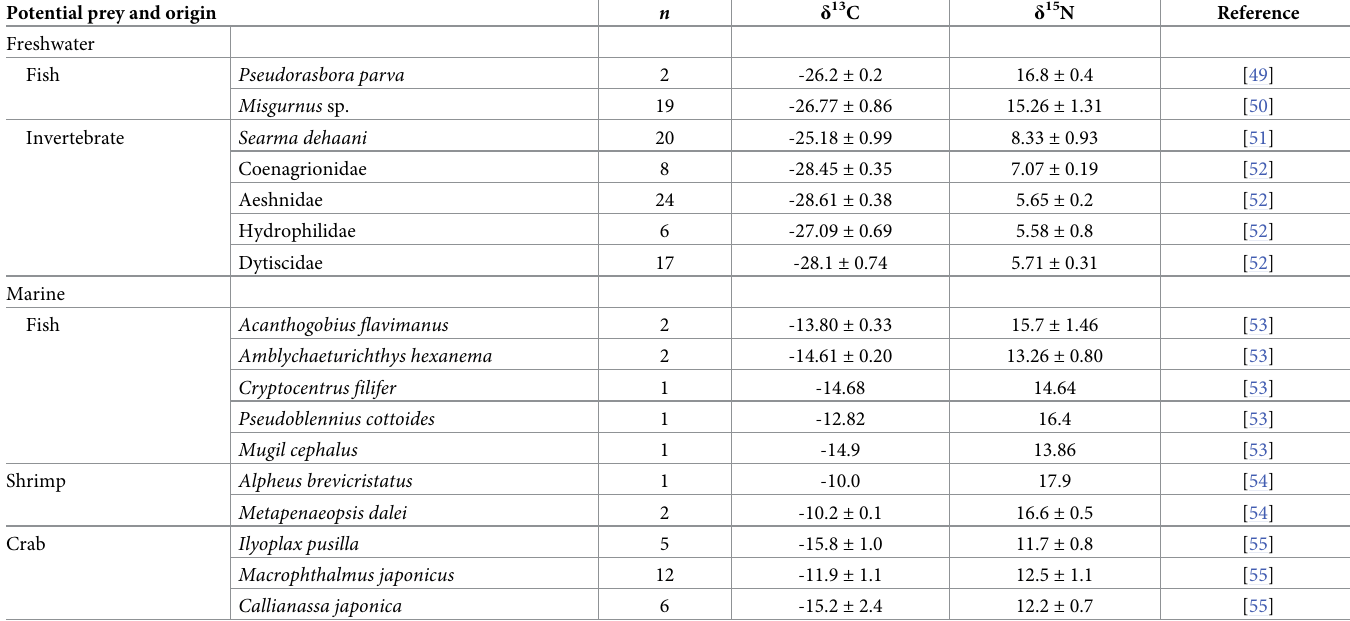
Table 2. δ 13 C and δ 15 N values (mean ± SD) of potential prey sources of Black-faced Spoonbill chicks collected in South Korea. Insect larvae in freshwater inverte- brates were only identified to the family